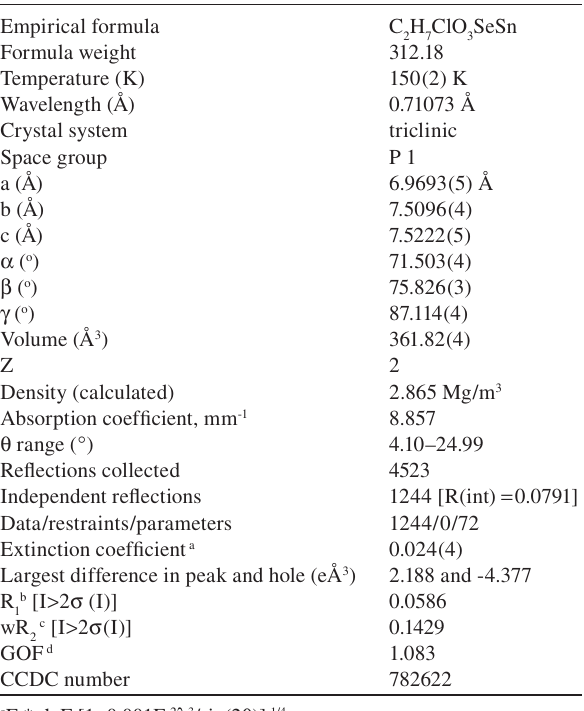
Table 1 Crystal data and structure refi